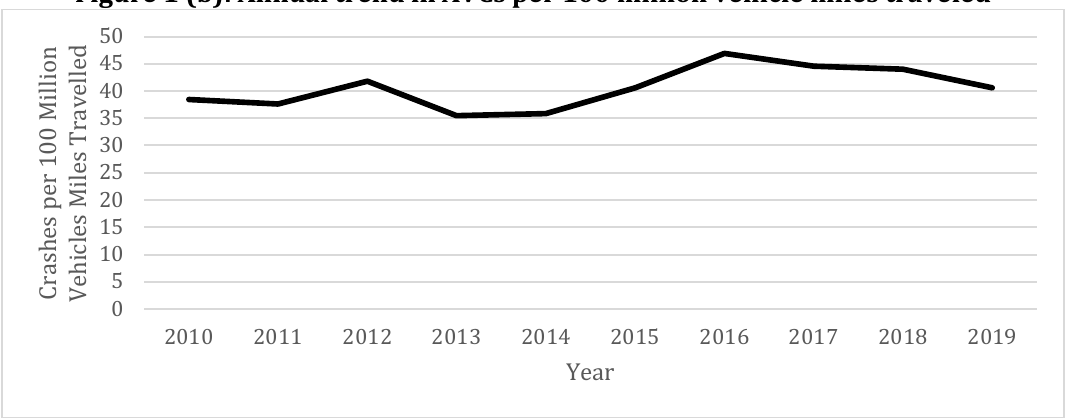
Figure 1 (b): Annual trend in AVCs per 100 million vehicle miles traveled